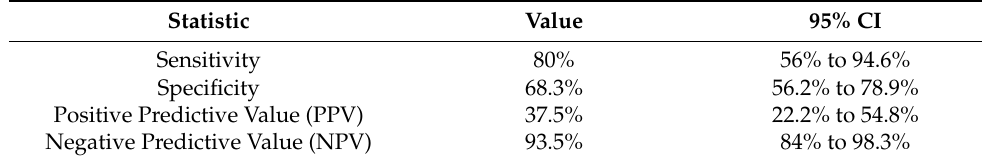
Table 4. Receiver Operating Characteristic (ROC) curve analysis.